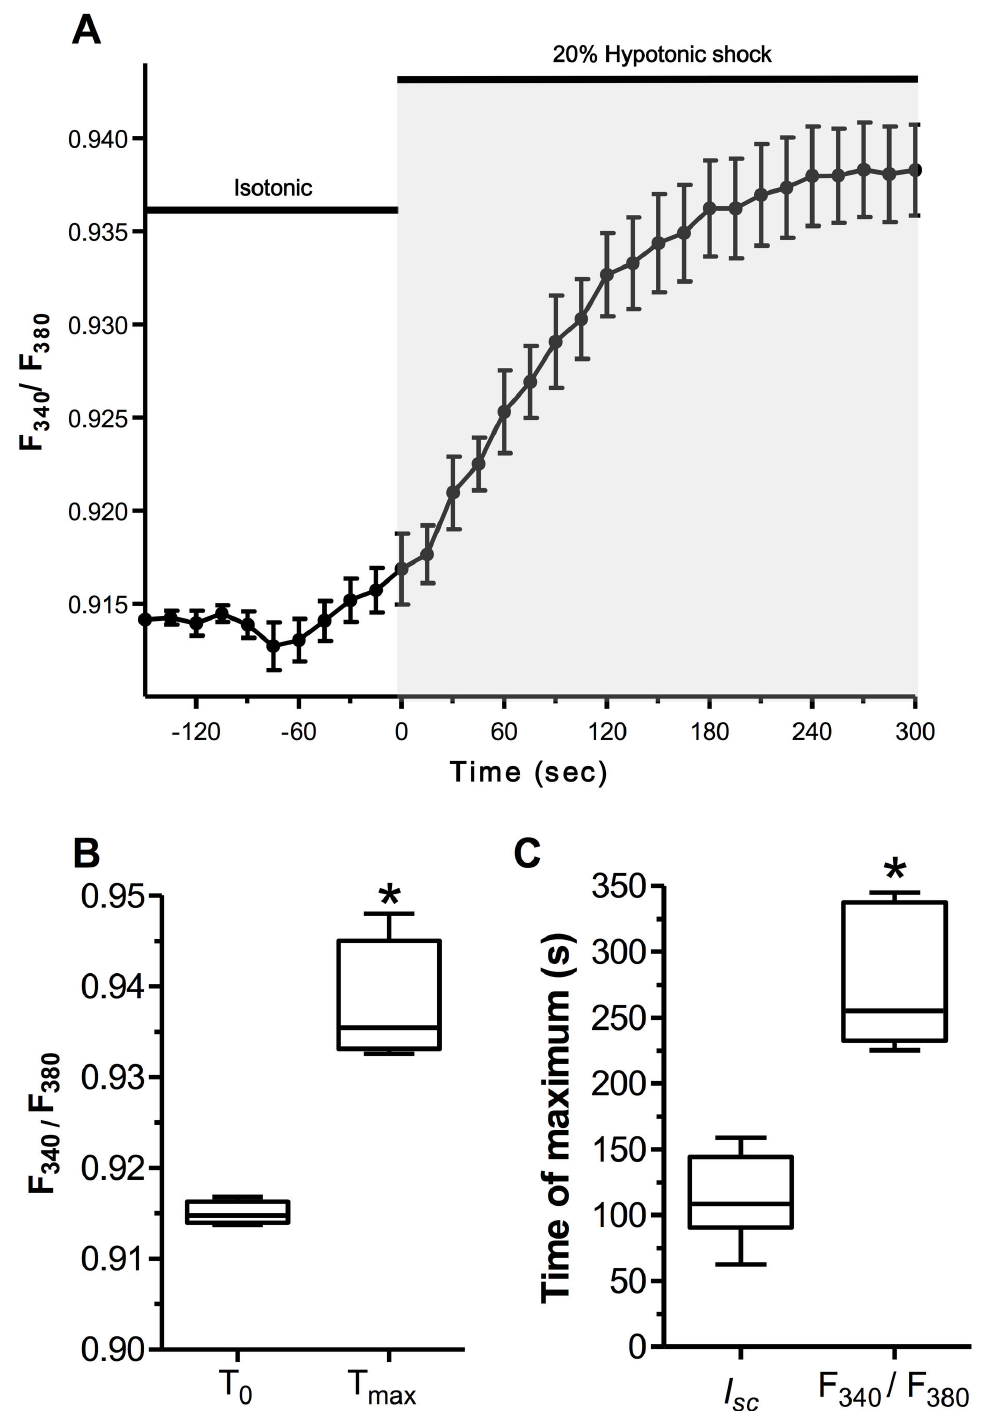
Figure 7. Kinetic of [Ca 2+ ] concentration rise after 20% hypotonic shock in alveolar epithelial cells. F i the [Ca 2+ ] rise detected by Fura-2 Ca 2+ fluorescence after 20% hypotonic shock in alveolar epithelial cells is depicted in A . i Hypotonic shock induced an immediate increment of intracellular [Ca 2+ ] the basal condition (T ). The F /F ratio rose significantly between T 0 340 380 time to reach maximum I and maximum [Ca 2+ ] was significantly different (N=17 for I sc i Test) ( C ). doi: 10.1371/journal.pone.0074565.g007 PLOS ONE |